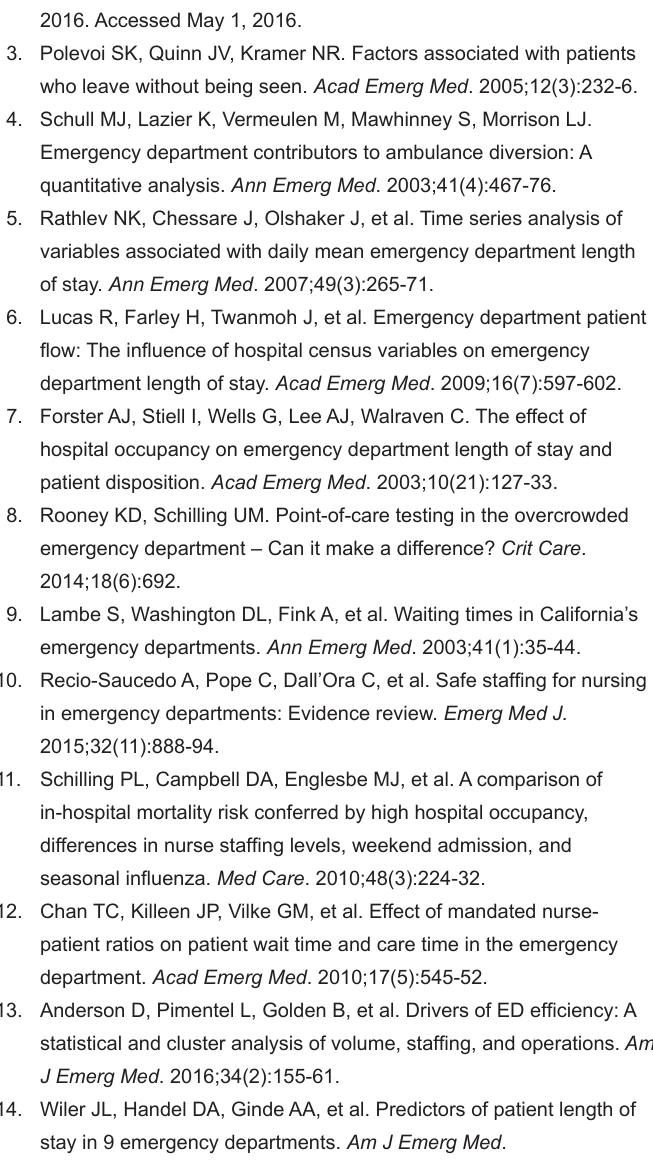
Covariates appearing in the model are evaluated at the following values: Daily ED Volume = 290.3, Hospital Occupancy = 249.7 (98.3%), ED Admission Rate =